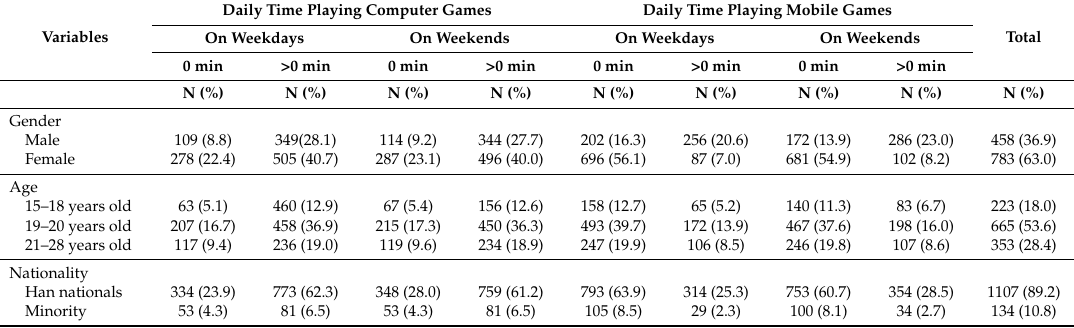
Table 3. Demographic characteristics of undergraduate students in Chongqing,